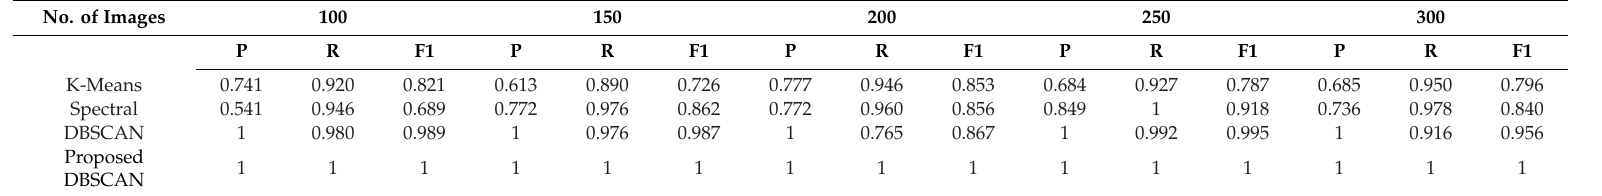
Table 4. Precision (P), Recall (R), F1-measure (F1) on 25 randomly selected identities from LFW dataset.